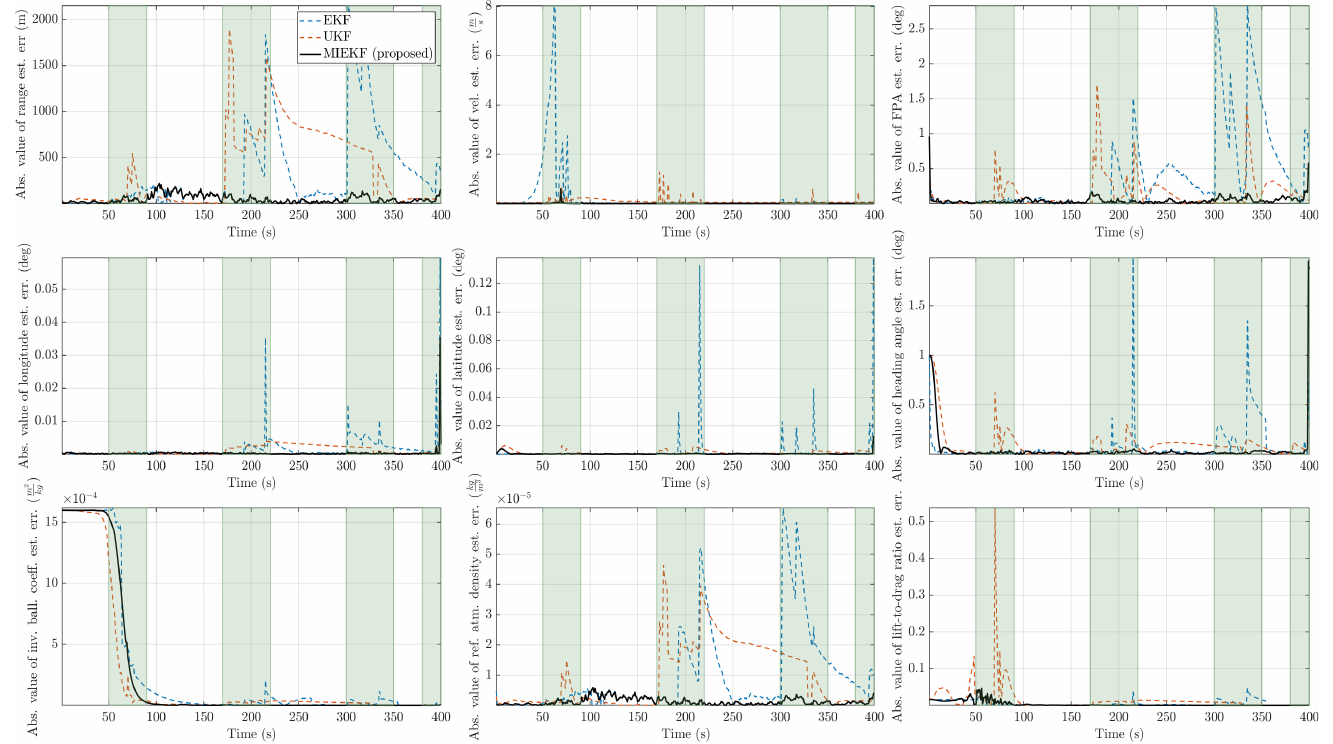
Figure 10. Absolute value of estimation errors with (cid:101) = 0.05 for the three candidate filters (the time intervals shaded in light green are intervals in which outliers are present).